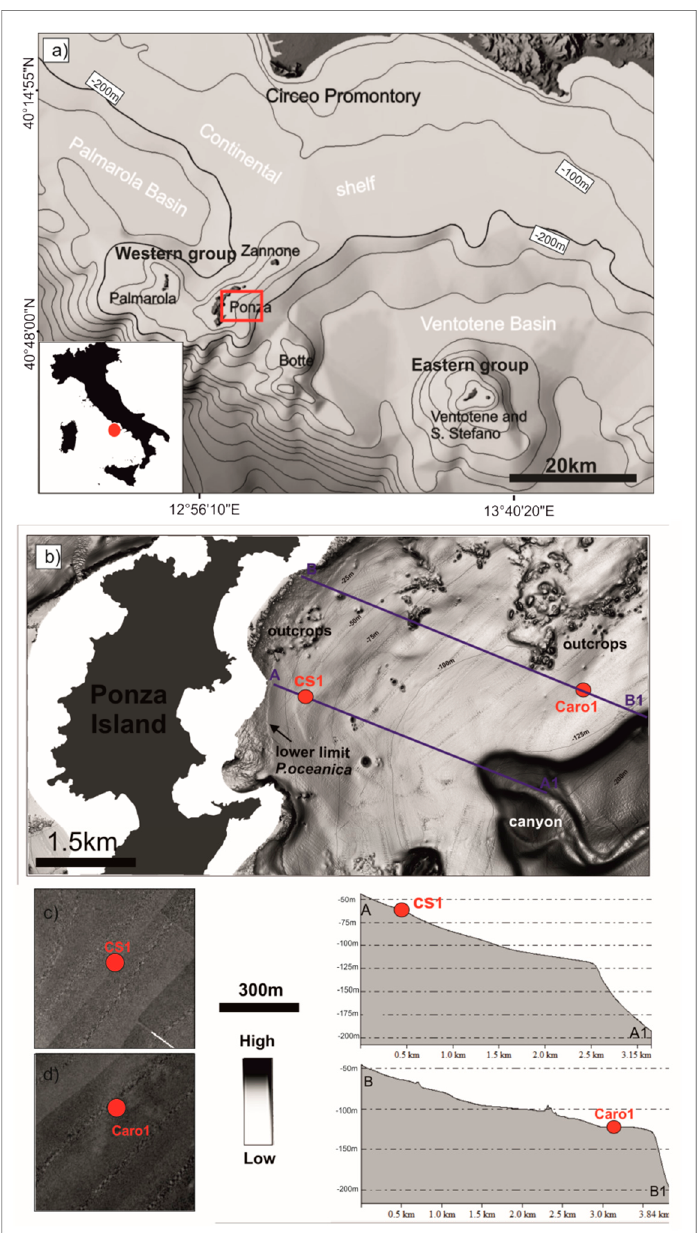
Figure 1. ( a ) Pontine Archipelago and sampling area (red rectangle); ( b ) shaded relief map of the Ponza Island offshore, showing the main geomorphologic features and the cores location (red dots); ( c , d ) multibeam derived backscatter signatures of the seafloor texture observed surrounding the cores, and bathymetric cross-sections showing the seafloor profiles reported as blue lines in Figure